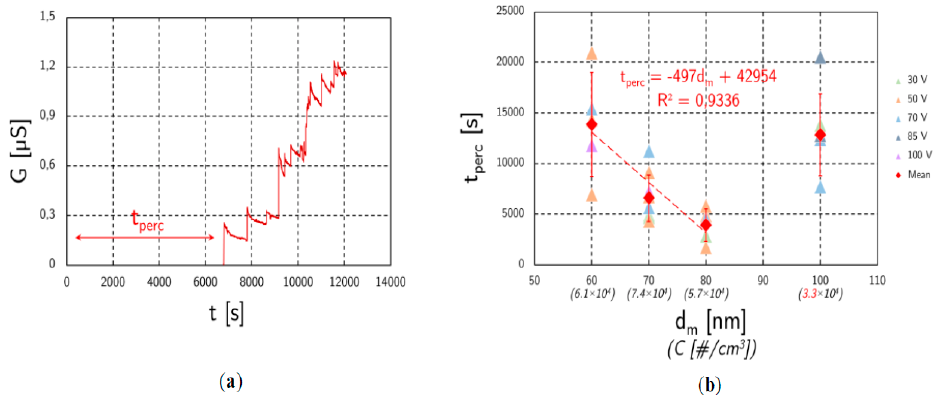
Figure 3. Electrostatic classification (DMA). ( a ) Typical soot sensor response to DMA classified aerosols (in this case, a 60 nm aerosol); ( b ) Overview of the percolation times for different size-concentrations.